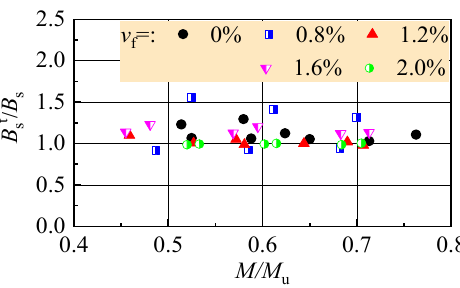
Figure 15. Test to calculation ratios of flexural stiffness.